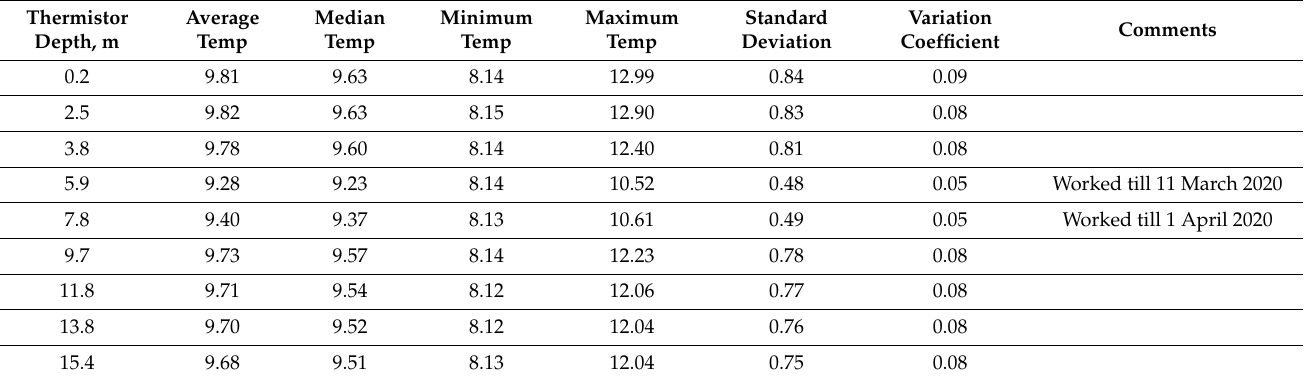
Table 2. Statistical parameters of water temperature at different depths during the second measure-